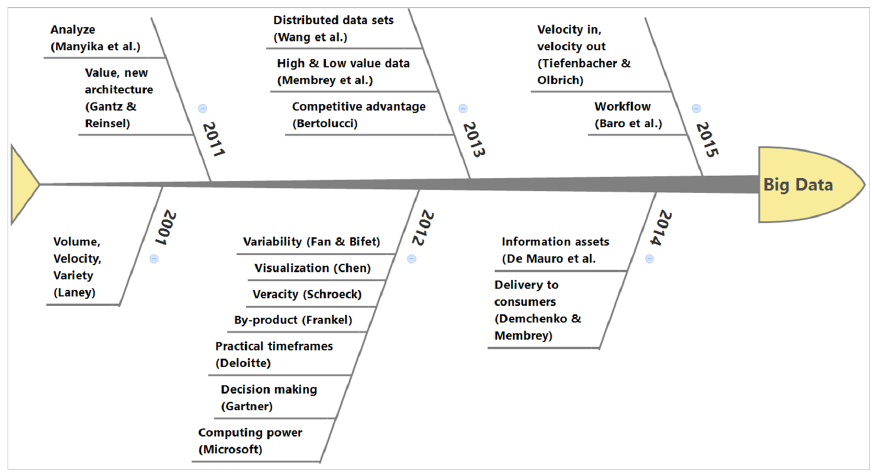
Fig. 4. Evolution of the definition of big